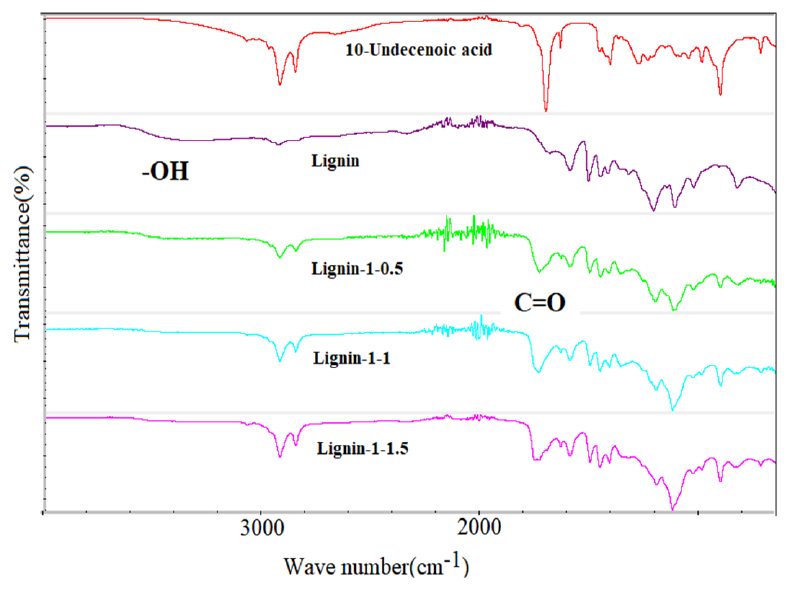
Figure 4. FT − IR of OFL, lignin and undecenoic acid.